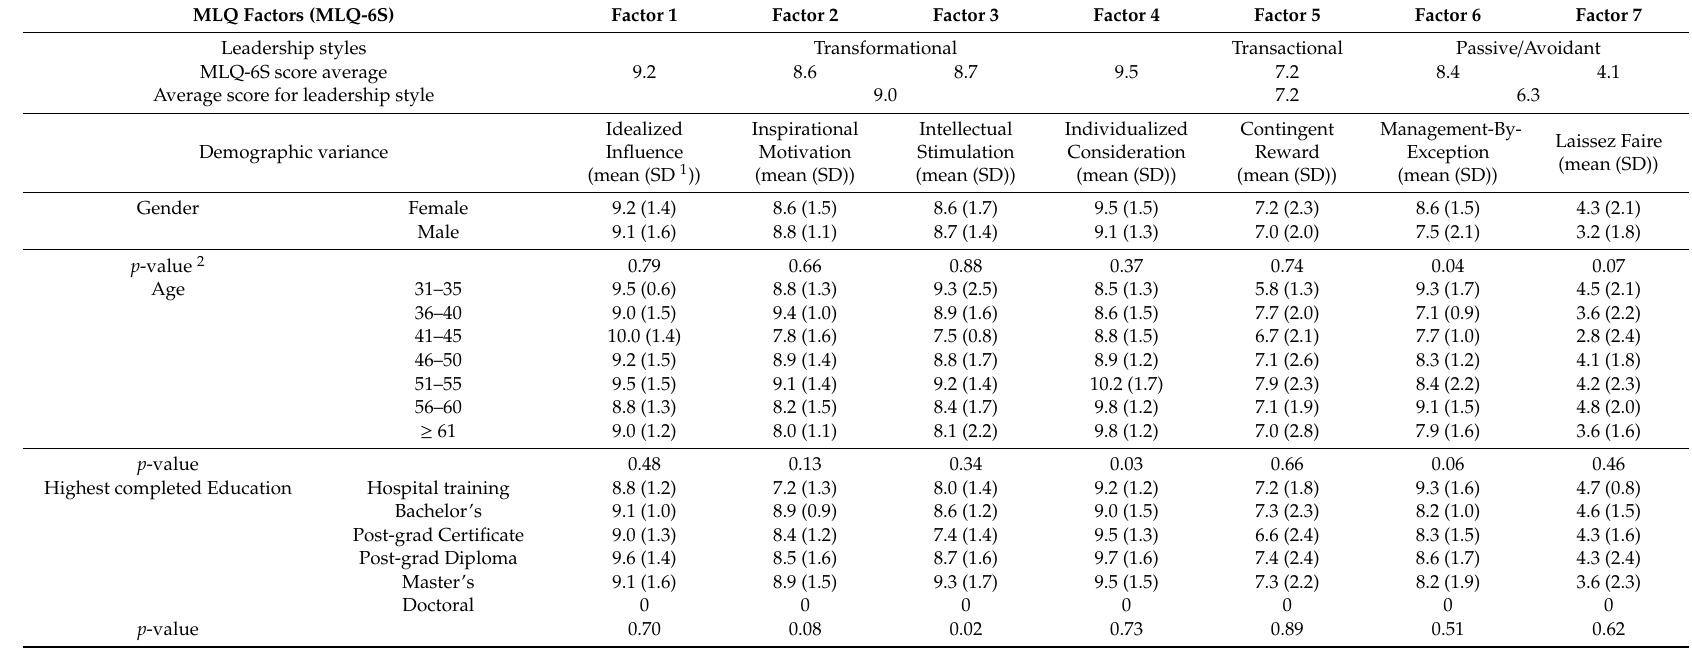
Table 3. Analysis of MLQ-6S scores by respondent